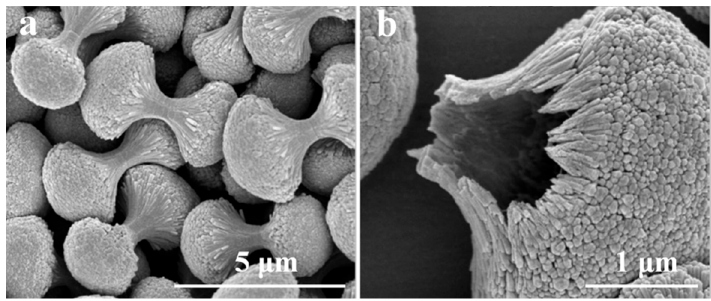
Figure 4. ( a ) SEM images of the double-cage nanorod-assembled ZnO structures and ( b ) several broken superstructures confirming that these kinds of structures are hollow (Reproduced with permission from [52], Copyright 2010, American Chemical Society).